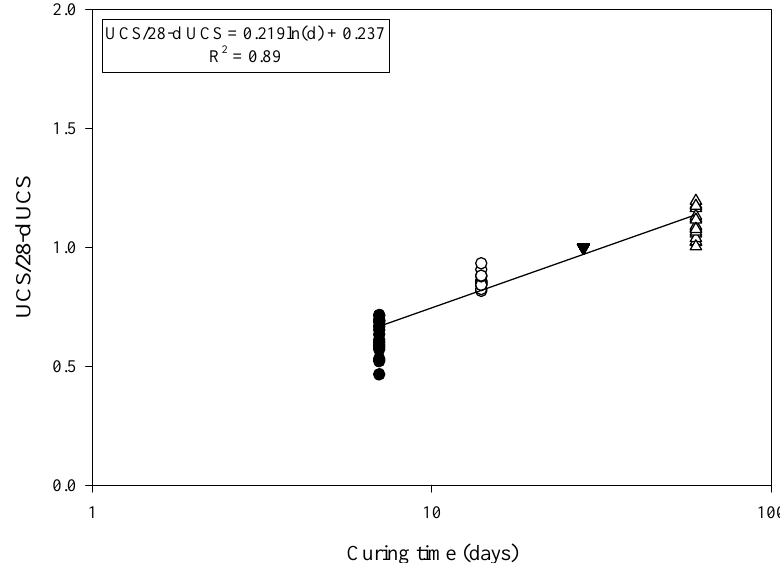
Figure 5. The relationship between UCS/28-d UCS and curing time of RCA-FAG samples.